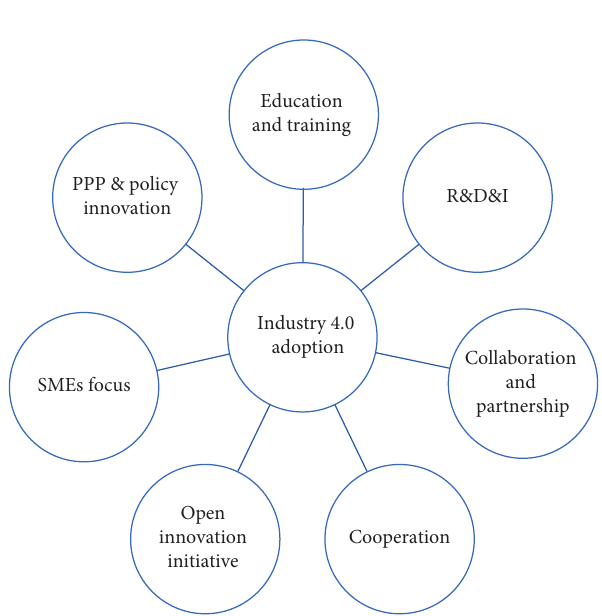
Figure 4: Strategies for industry 4.0 adoption in the